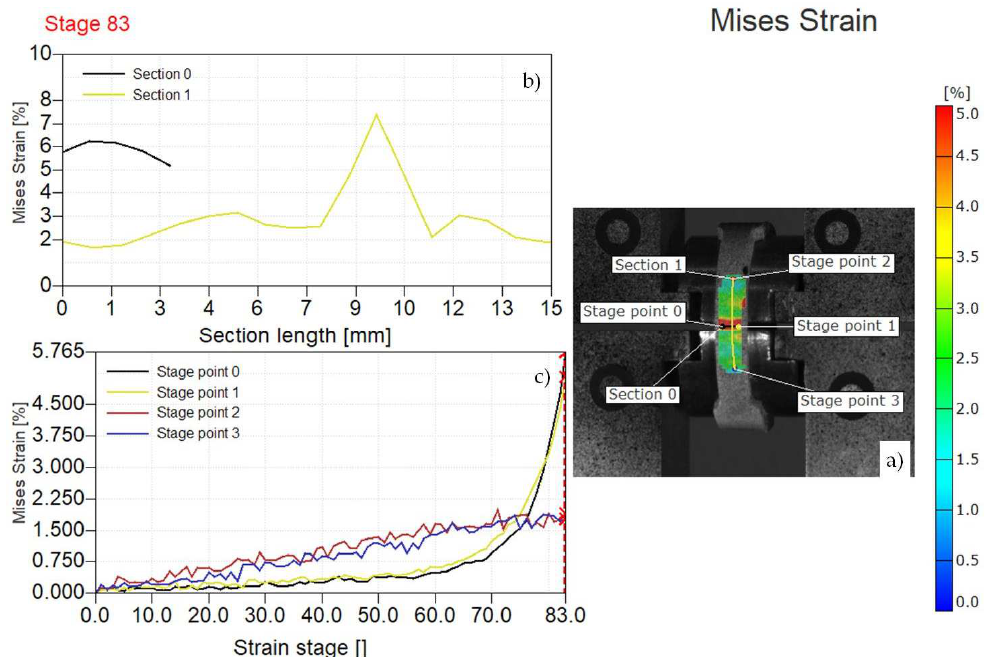
Figure 7. Visualization of von Mises strain field before fracture for Double PRTS specimen with 90% infill: ( a ) visualization of von Mises strain field at stage just before fracture; ( b ) von Mises strain value with respect to the section length; ( c ) von Mises strain value change over time.